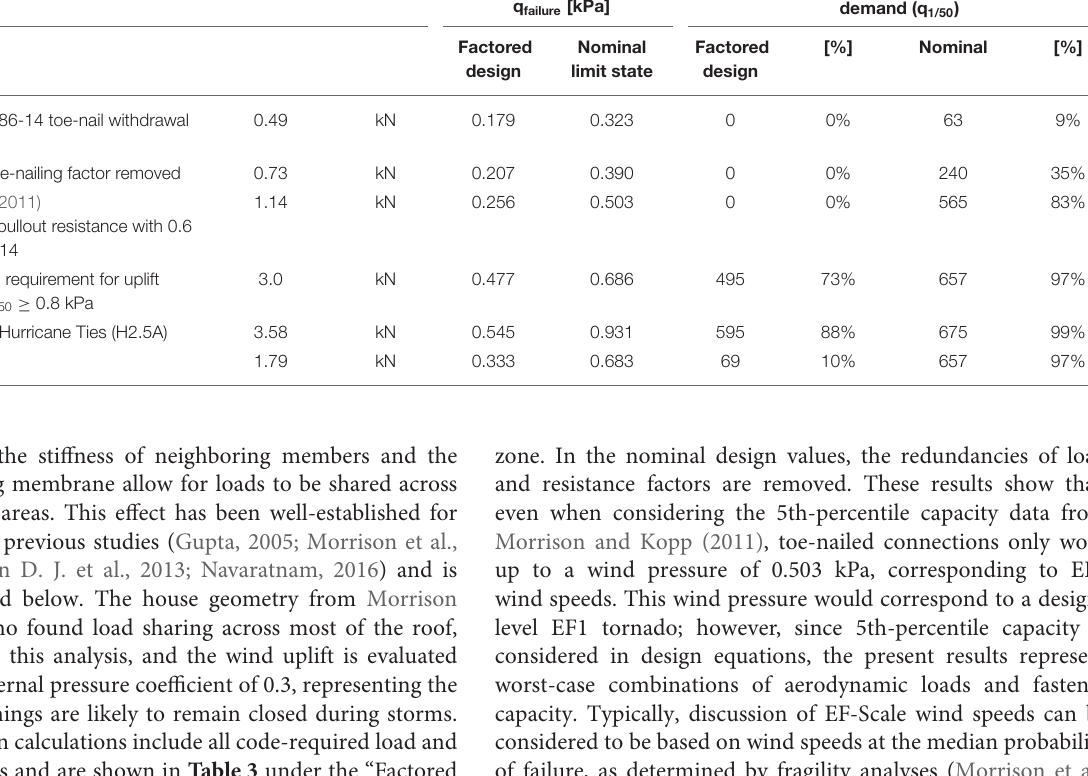
TABLE 3 | Design check for RTWCs showing factored and unfactored design wind pressures, as well as a comparison to the design wind pressures in NBCC (Canadian Commission on Building and Fire Codes, 2015) climate zones. RTWC design